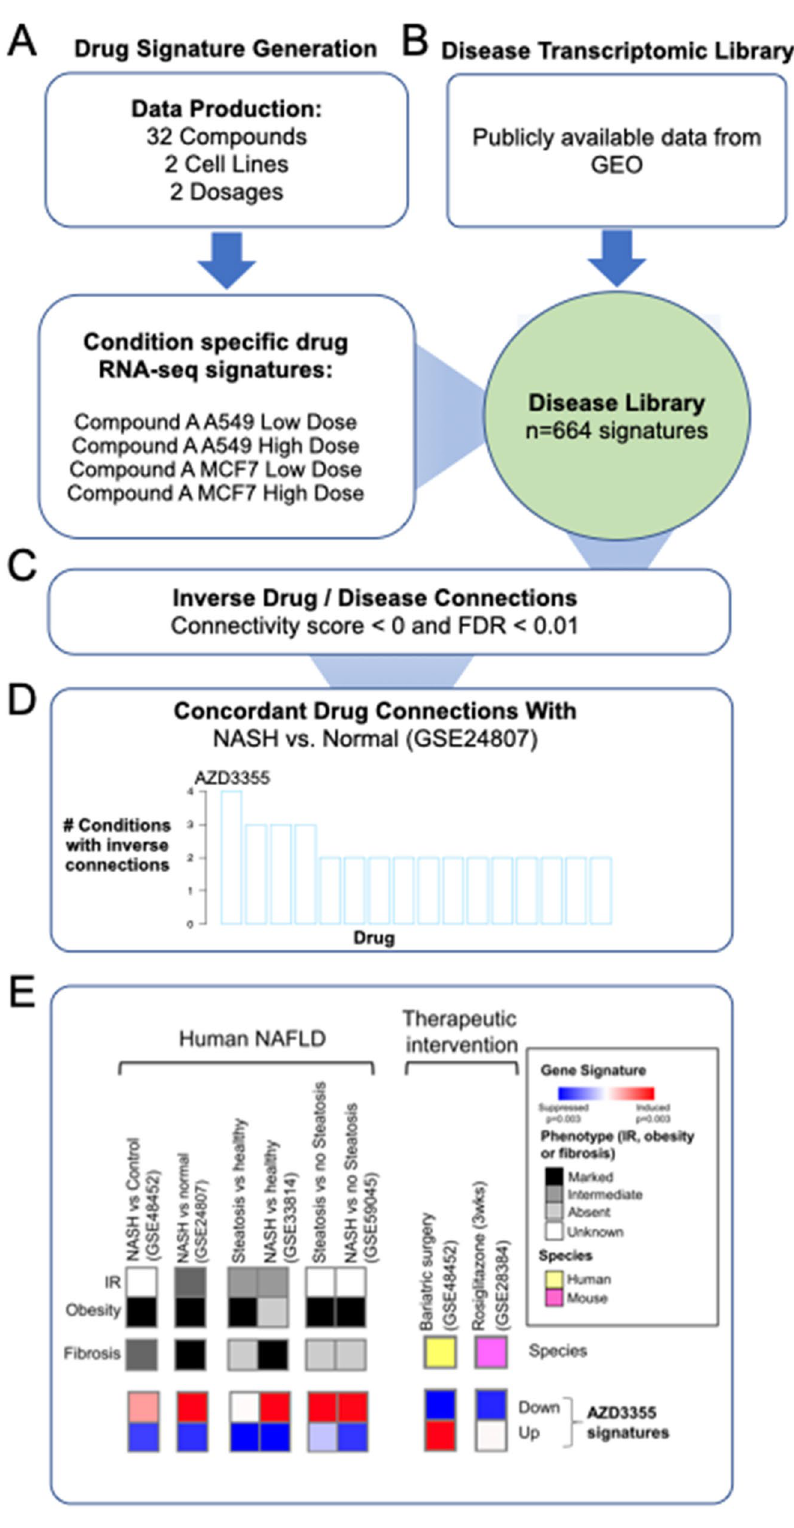
Figure 1. Computational drug repurposing identifying AZD3355 as a potential treatment for NASH. ( A ) We generated RNA-sequence profiles for 32 drugs, across four conditions to define condition specific drug signatures, ( B ) which were then compared with a large library of publicly available disease gene expression profiles using a connectivity mapping approach. ( C , D ) Significant (FDR < 0.01), inverse connections were found between all four AZD3355 signatures and a NASH gene expression signature (GSE24807). ( E ) In silico validation of AZD3355 in additional human and therapeutic NAFLD hepatic transcriptomic datasets. AZD3355 perturbation signatures were inversely enriched in human NAFLD (left), and positively enriched in datasets testing previously validated NAFLD therapies in human and mice (right). Abbreviations: IR, insulin